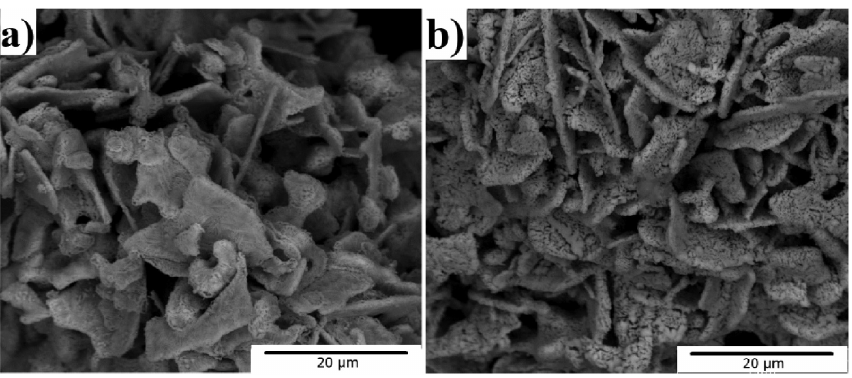
Fig. 10: Morphologies of Mo 2 C by reducing MoO 2 powders in CO for 100 min: (a) 1323 K, (b) 1393 K (SEM